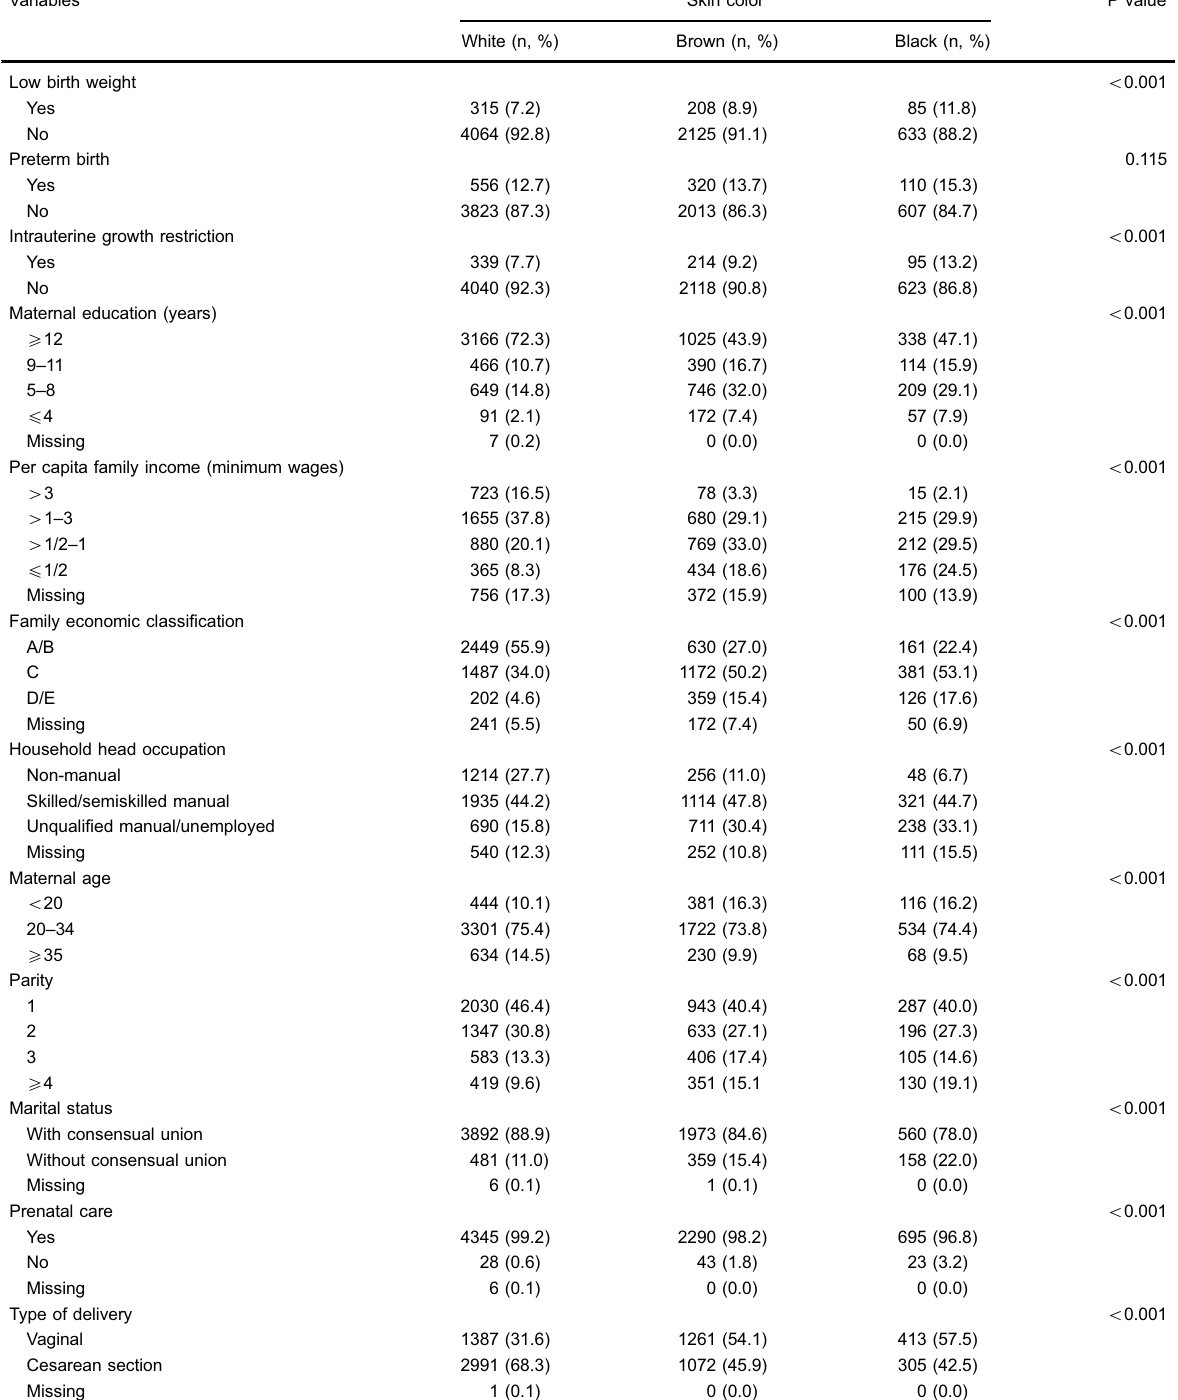
Table 2. Perinatal, socioeconomic, and biological variables according to maternal skin color in the Ribeirão Preto birth cohort,